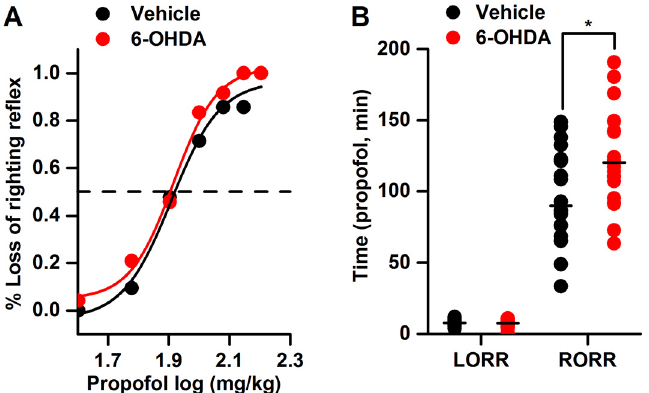
Fig 3. The effects of the bilateral lesioning of the dopaminergic VTA neurons on the propofol ED50 value and the times of onset of and recovery from propofol anesthesia. 6-OHDA: 6-hydroxydopamine; LORR: loss of the righting reflex; RORR: return of the righting reflex. * p < 0.05 vs . vehicle; n = 21 for the vehicle group and n = 24 for the 6-OHDA